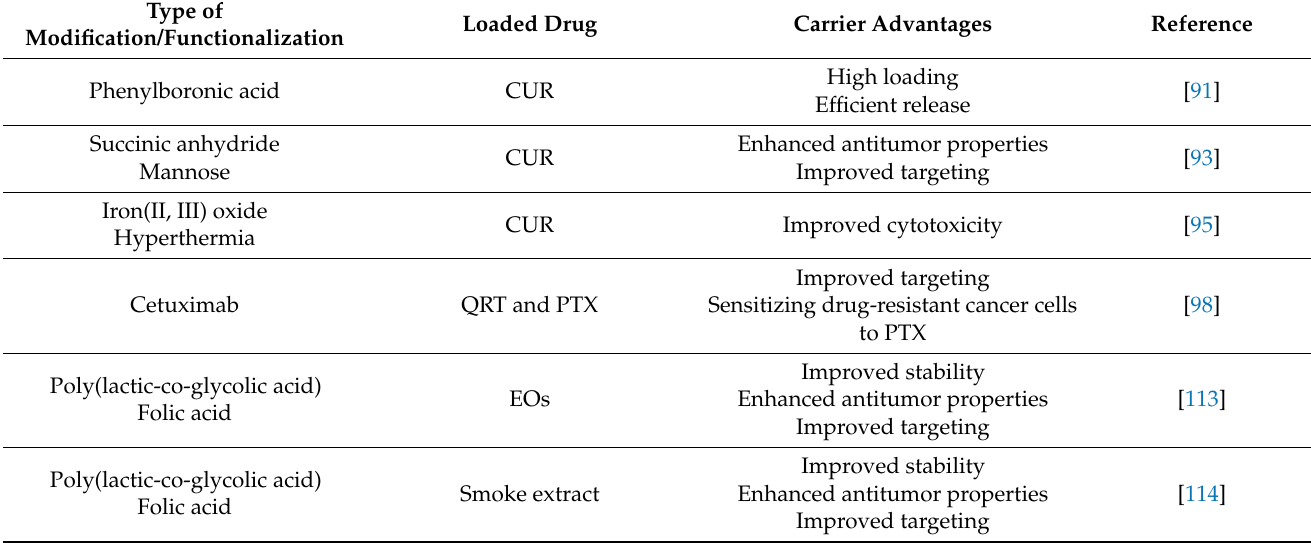
Table 4. Examples of CS-based nanoparticles for effective targeted delivery of potential anticancer